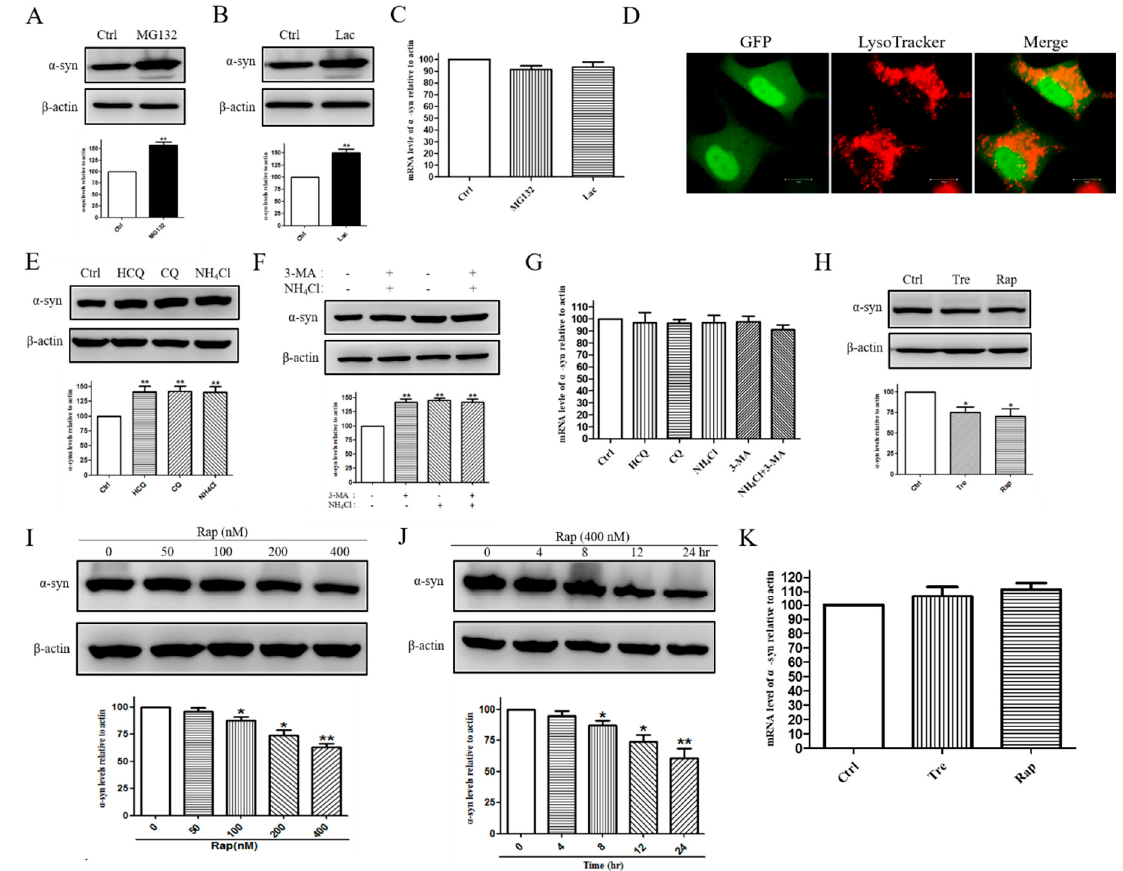
Figure 2. The E46K mutant α -syn is degraded by a proteasome and a macro-autophagy pathway. ( A ) PC12 cells stably overexpressing the E46K mutant α -syn were treated with 10 µ M MG132 for 24 h. Cells were lysed and subjected to SDS-PAGE using an anti- α -syn antibody. ( B ) Stable PC12 cells overexpressing E46K mutant α -syn were treated with 10 µ M Lac for 24 h. α -Syn levels were assessed by using an anti- α -syn antibody. ( C ) Cells were treated with 10 µ M MG132 or 10 µ M Lac for 24 h and mRNA levels of the E46K mutant α -syn were detected by using RT-PCR. ( D ) Cells were labeled with Lyso-Tracker for 20 min and visualized by using a confocal microscopy. Representative images were shown. Scale bar: 10 mm. ( E ) Cells were treated with 100 µ M CQ, 30 µ g/mL HCQ, and 20 mM NH 4 Cl for 24 h. Cells were lysed and subjected to SDS-PAGE using an anti- α -syn antibody. ( F ) Cells were incubated with 10 mM 3-MA, 20 mM NH 4 Cl, and a combination of 3-MA and NH 4 Cl for 24 h. Cells were lysed and subjected to immunoblot analysis using an anti- α -syn antibody. ( G ) Cells were treated with 100 µ M CQ, 30 µ g/mL HCQ, 20 mM NH 4 Cl, 10 mM 3-MA, and a combination of NH 4 Cl with 3-MA for 24 h. RT-PCR was conducted to assess the mRNA levels of E46K mutant α -syn. ( H ) PC12 cells were treated with 100 mM Tre and 200 nM Rap for 24 h and α -syn levels were assessed using Western blotting. ( I ) PC12 cells were treated with Rap for indicated concentration and harvested for immunoblotting for α -syn. ( J ) PC12 cells were treated with 400 nM Rap for the indicated periods of time and cell extracts were subjected to the immunoblot. Representative blots of three independent experiments were shown. β -actin levels demonstrate equal loading. ( K ) Cells were treated with 100 mM Tre of 400 nM Rap for 24 h and mRNA levels of E46K mutant α -syn were detected by RT-PCR. Data were expressed as means ± SD for three independent experiments performed in triplicate. * p < 0.05, ** p < 0.01 compared with the control group.